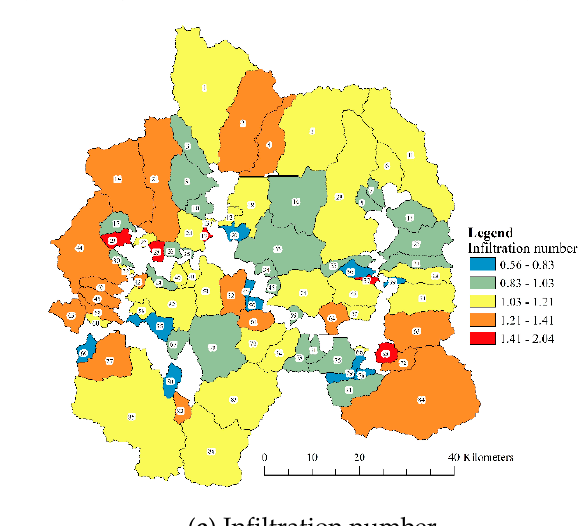
Figure 5. Linear features parameters ( a ) bifurcation ratio; ( b ) stream frequency; ( c ) the drainage density; ( d ) the length of overland flow; ( e ) infiltration number.